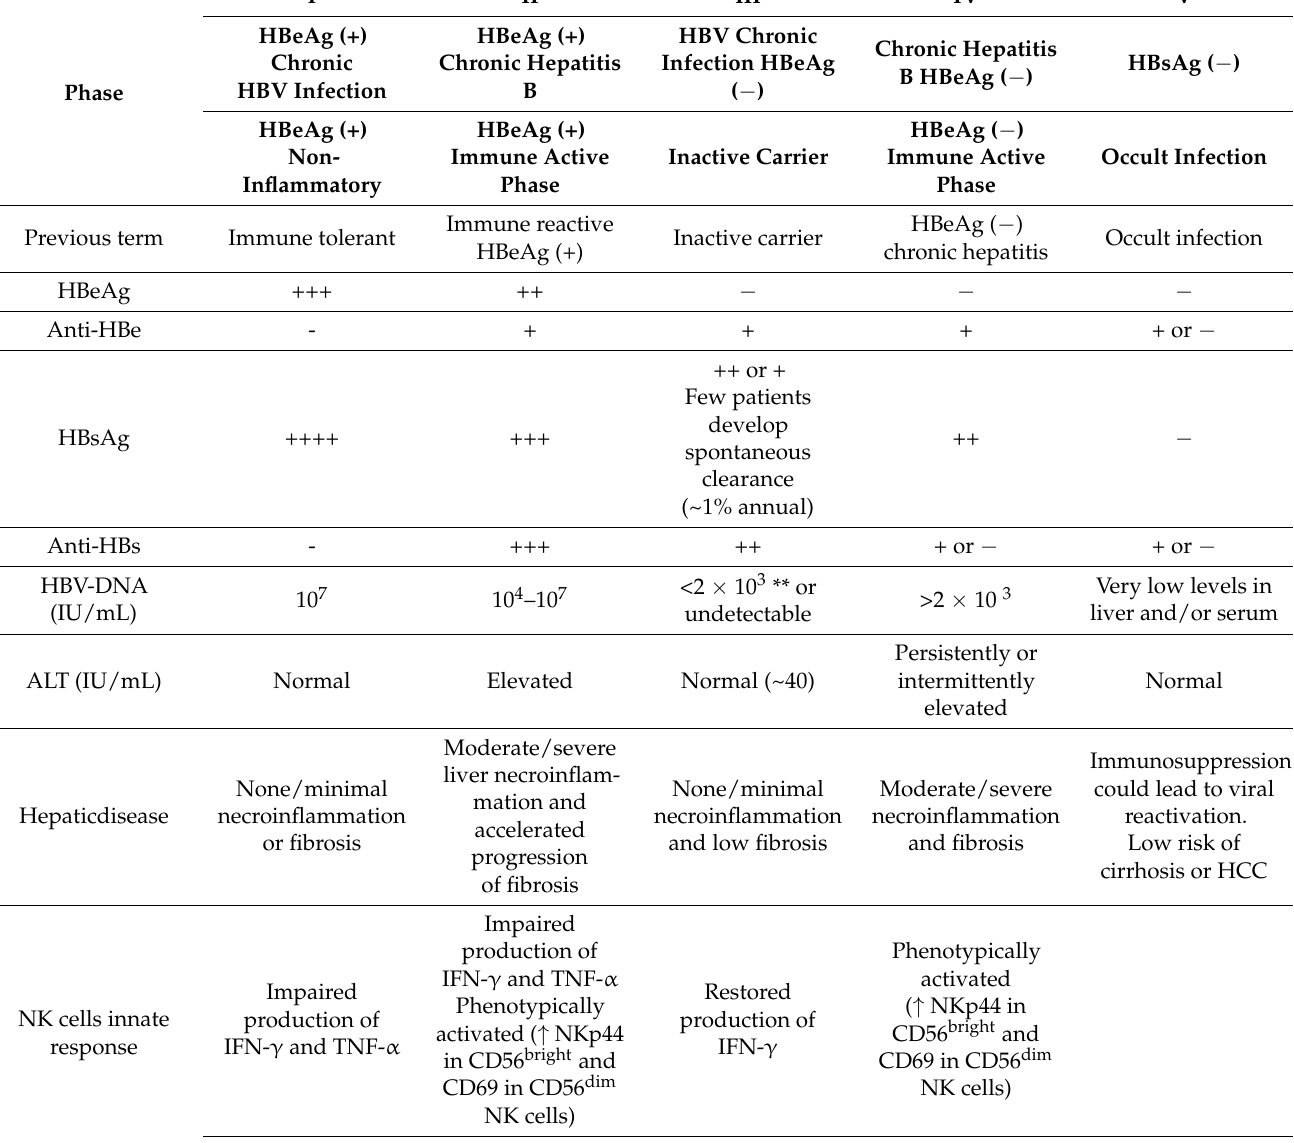
Table 2. Viral and serological markers; and NK and T cells responses during chronic HBV